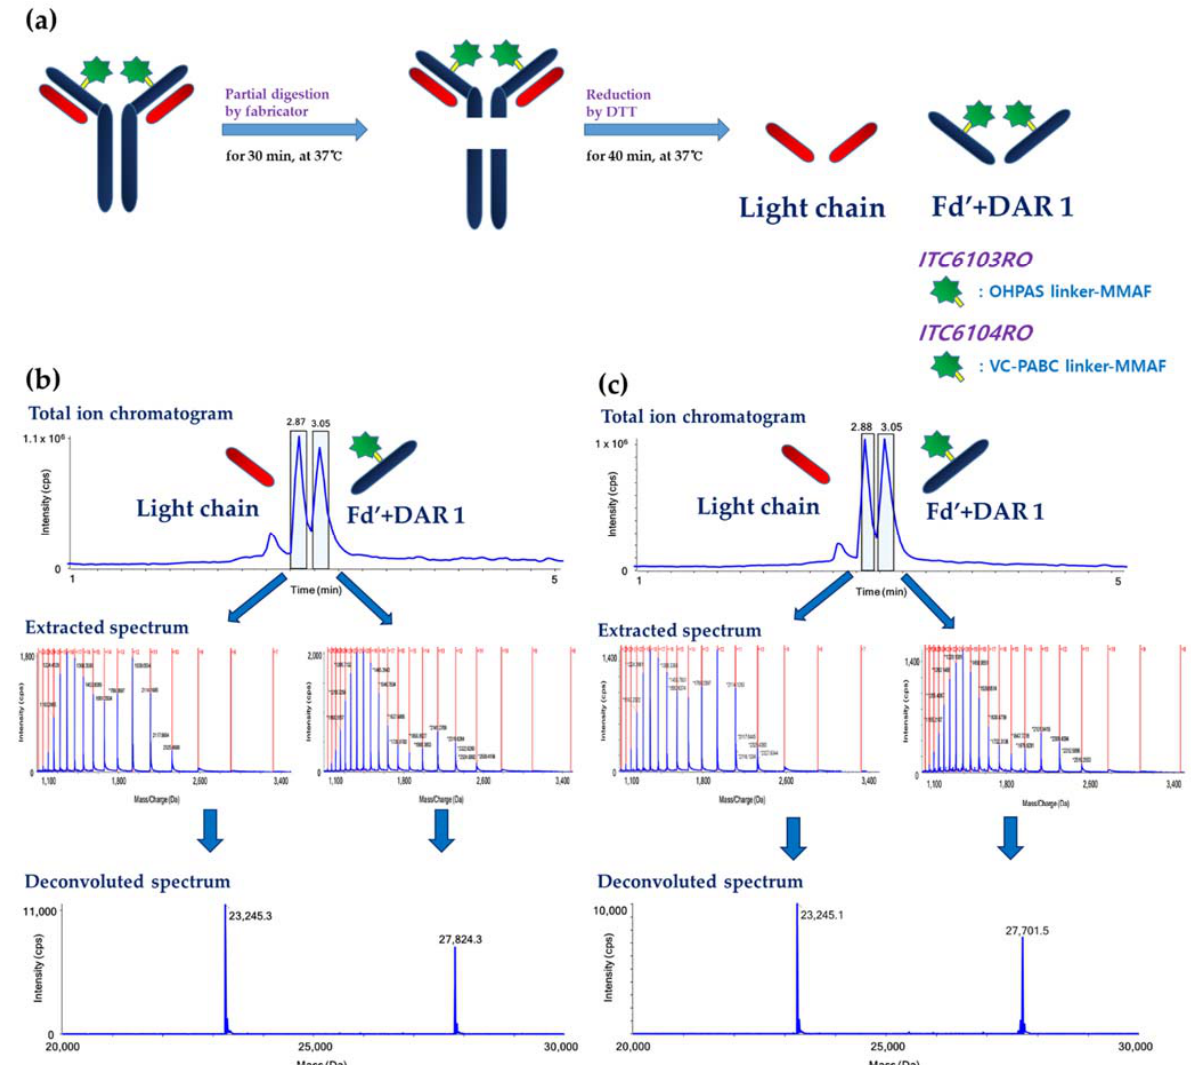
Figure 5. ( a ) Workflow of intact ADC mass analysis at subunit intact protein level by partial digestion and reduction, and the representative total ion chromatogram (TIC) with the extracted and the deconvoluted spectra of the quality control sample for ( b ) ITC6103RO and ( c ) ITC6104RO.